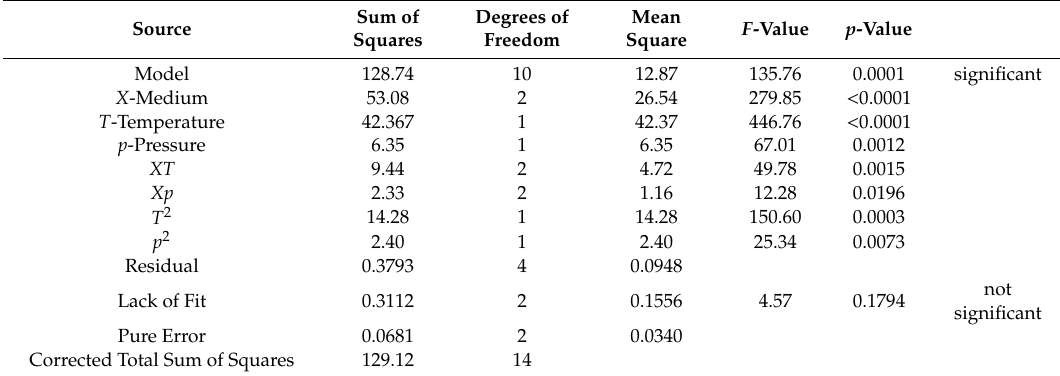
Table 4. Results of ANOVA for the quadratic model of the CO 2 concentration in